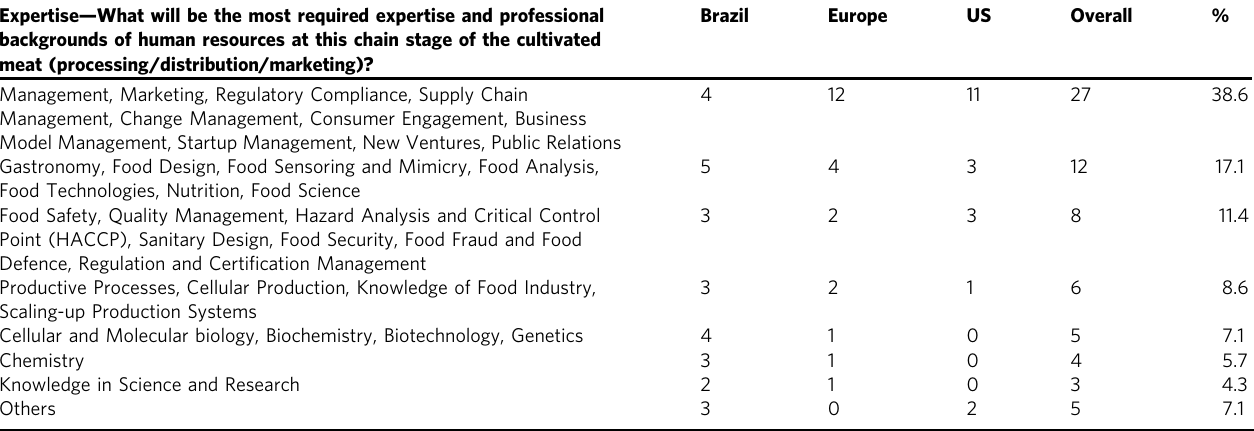
Table 14 Results regarding the most required expertise and background knowledge of human resources at the third stage of the cultivated meat value chain in Brazil ( N = 21), Europe ( N = 18) and the United States ( N = 17), using an open-ended question. Expertise — What will be the most required expertise and professional backgrounds of human resources at this chain stage of the cultivated meat